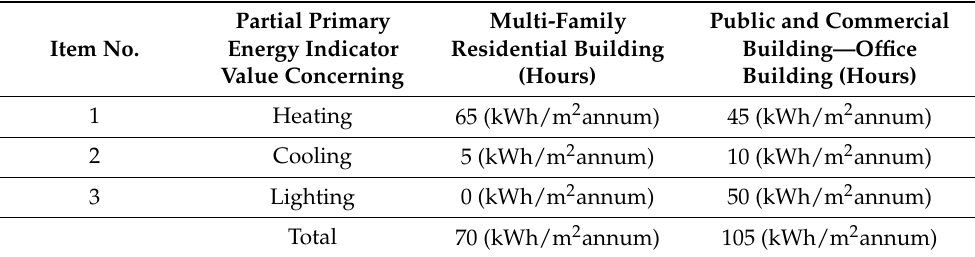
Table 6. Permissible primary energy indicator values for both functions of the building.